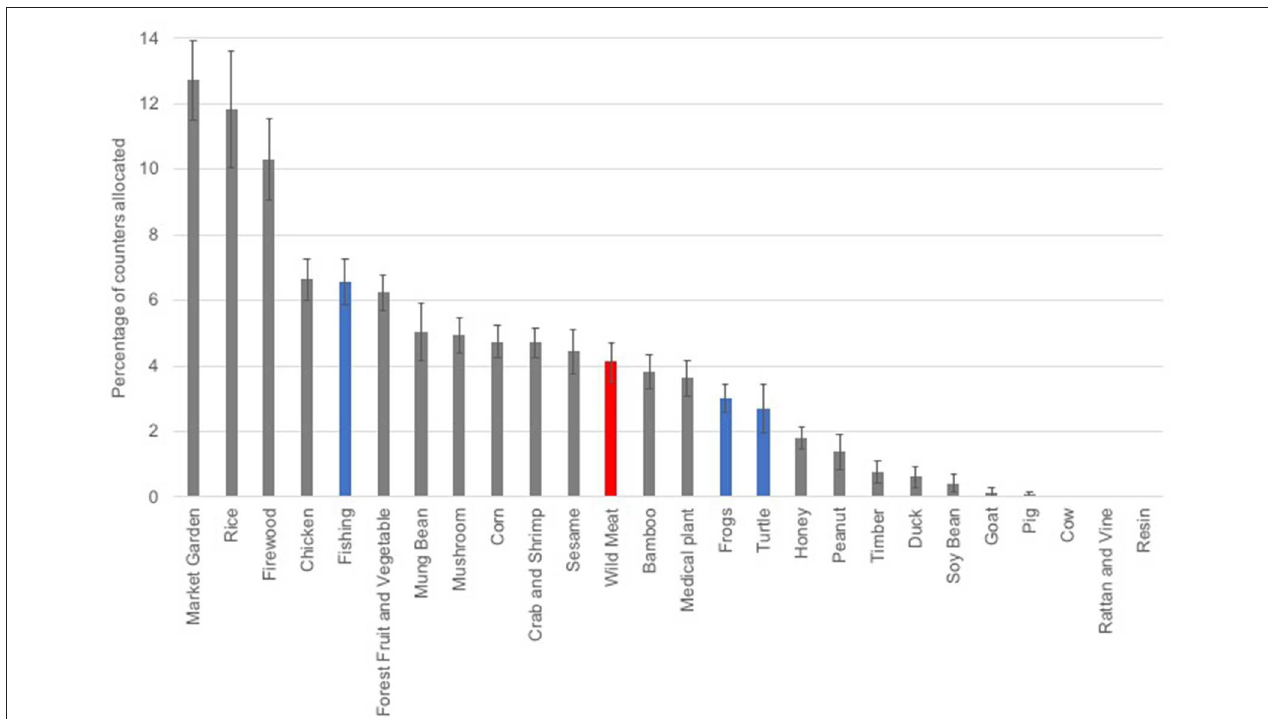
FIGURE 3 | Average non-cash income scores per household given for agricultural, NTFP, and fishing products during the PRA exercise. N = 35 households.